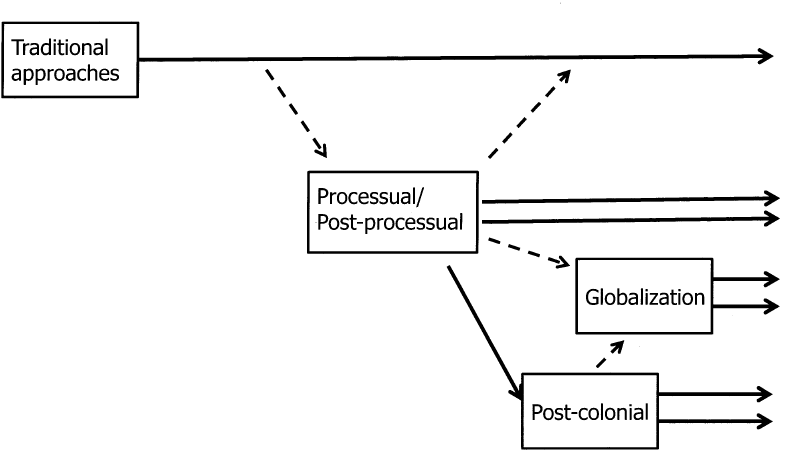
Figure 2: Schematic representation of the diversi fi cation of theoretical Roman archaeology over